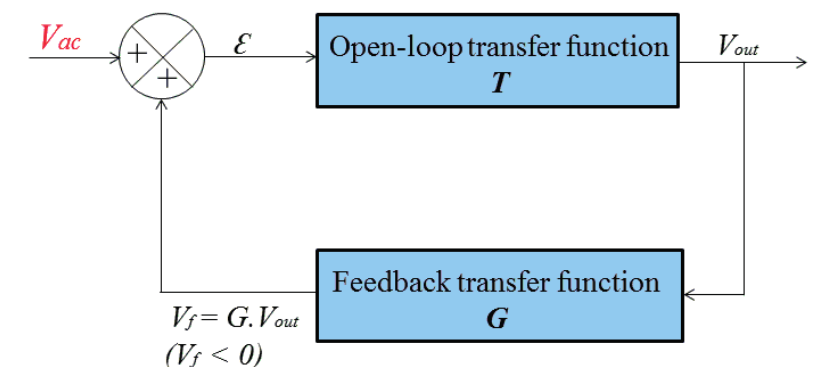
Figure 7. The functional diagram of the closed-loop of the amplitude